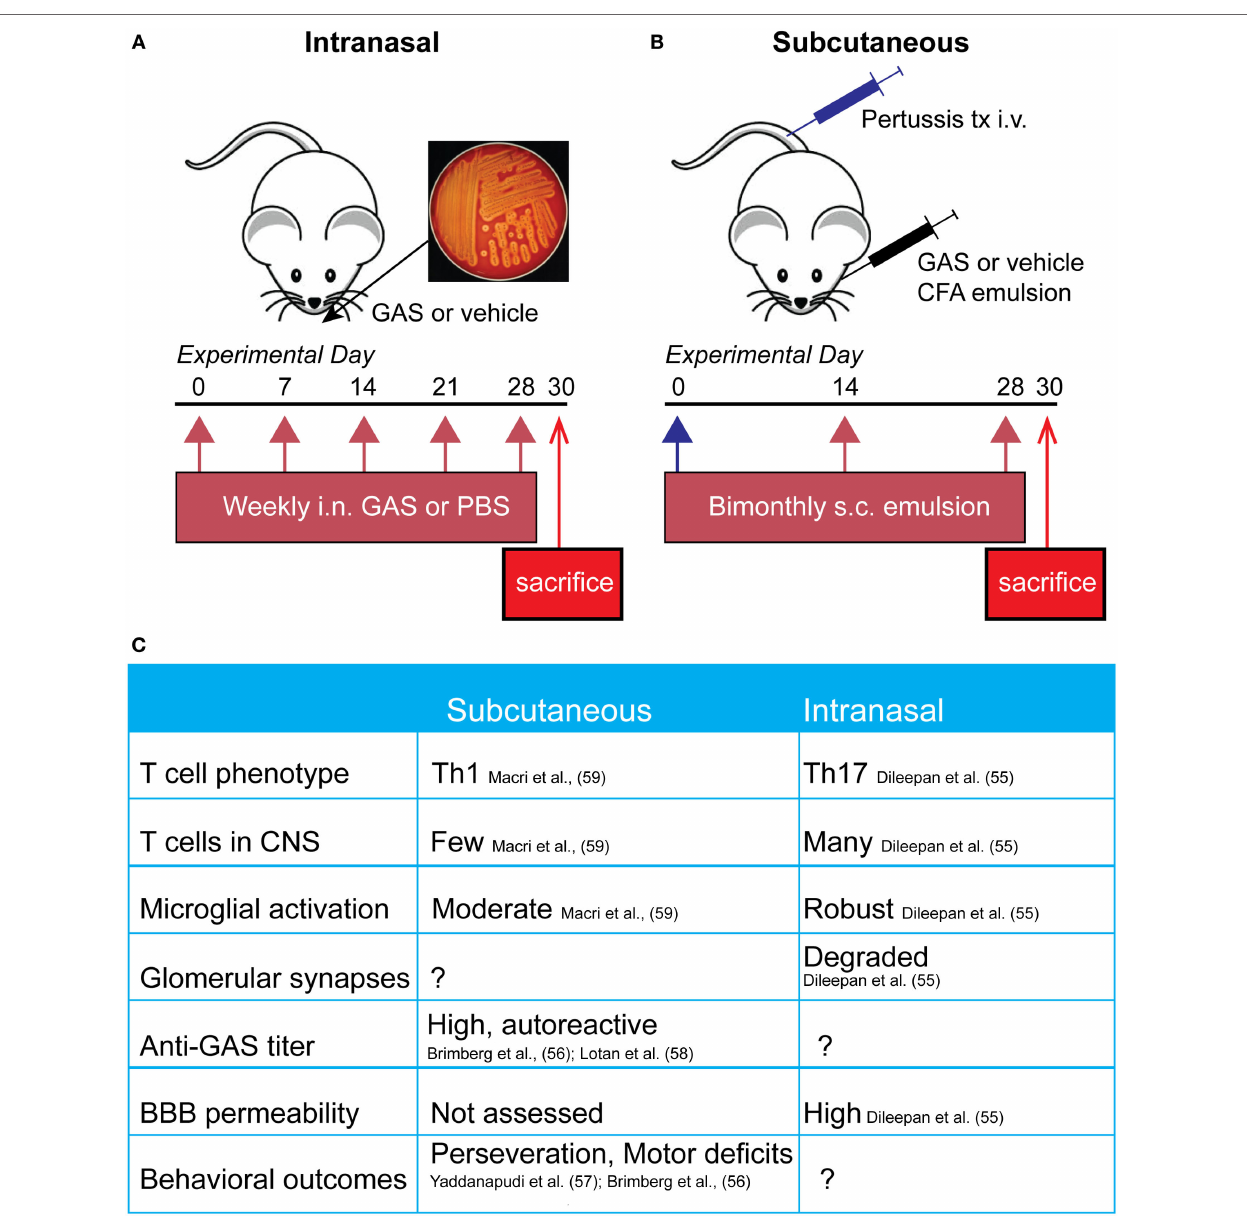
FiGURe 1 | Comparison of mouse pediatric autoimmune neuropsychiatric disorders associated with streptococcal infections (PANDAS)/Sydenham’s chorea (SC) models . (A) Schematic representing the initiation of the intranasal model, where mice receive live bacteria intranasally once a week for 5 weeks prior to sacrifice. (B) Subcutaneous GAS exposure involves adjuvant and antigen exposure three times, every 2 weeks, following an initial boost with intravenous pertussis toxin. (C) Comparison of immune, neural, and behavioral outcomes after each route of GAS exposure. Investigators have used either subcutaneous or intranasal routes to induce an immune response against S. pyogenes [Group A Streptococcus (GAS)] in efforts to understand the mechanisms underlying the behavioral and motor symptoms characteristic of PANDAS and SC patients. The former route necessitates opening the blood–brain barrier (BBB) artificially using B. pertussis toxin, whereas the latter features intranasal inhalation of live bacteria to trigger a Th17 response in nasal tissue that is directly communicated to the brain along the olfactory